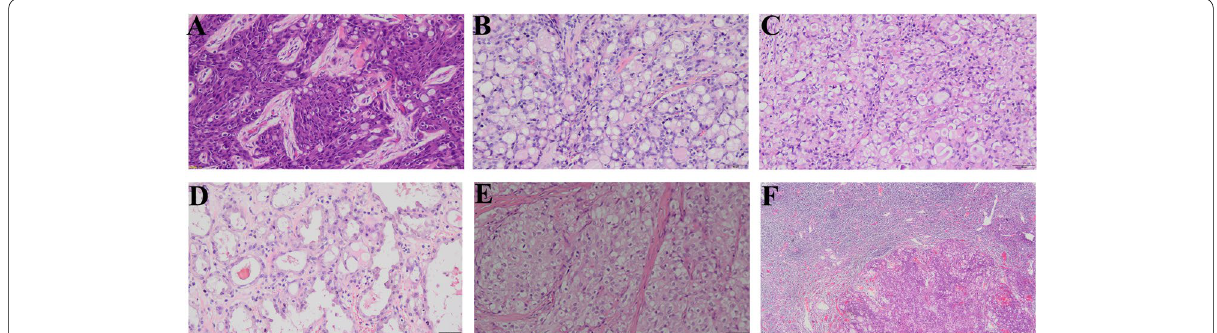
Fig. 1 SBC (hematoxylin and eosin staining). A Solid area separated by a fibrous septum with intracellular mucinous vacuoles and eosinophilic secretory vacuoles. B , C Solid and microcystic structure with intracellular and extracellular vacuoles. D Tubular area with intracellular and extracellular eosinophilic vacuoles. E Solid structure separated by fibrous septum with extracellular eosinophilic secretion. F Metastatic SBC components in axillary lymph nodes in Patient 2